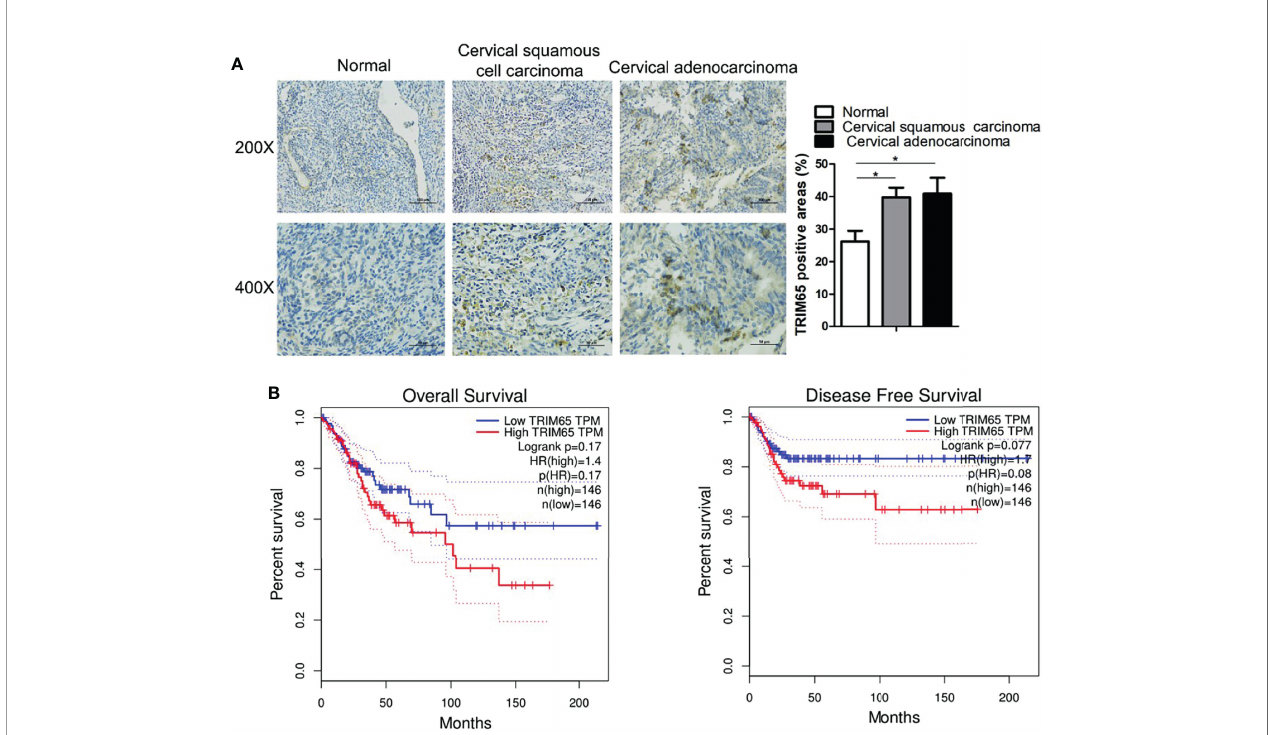
FIGURE 1 | TRIM65 expression is increased in human cervical cancer tissues. (A) Representative images of TRIM65 by IHC staining were shown on human cervical tumor and non-tumor tissues from the First Af fi liated Hospital of Nanchang University. Scale bar = 100 m m (Upper panel), scale bar = 50 m m (Bottom panel). (B) The prognostic value of TRIM65 protein for overall survival (left) and disease-free survival (right) was determined by Kaplan – Meier analyses. Data is from TCGA ’ s cervical carcinoma data set. Data are presented as mean ± SD. The experiments were repeated three times independently and the data of one representative experiment was shown. *p <